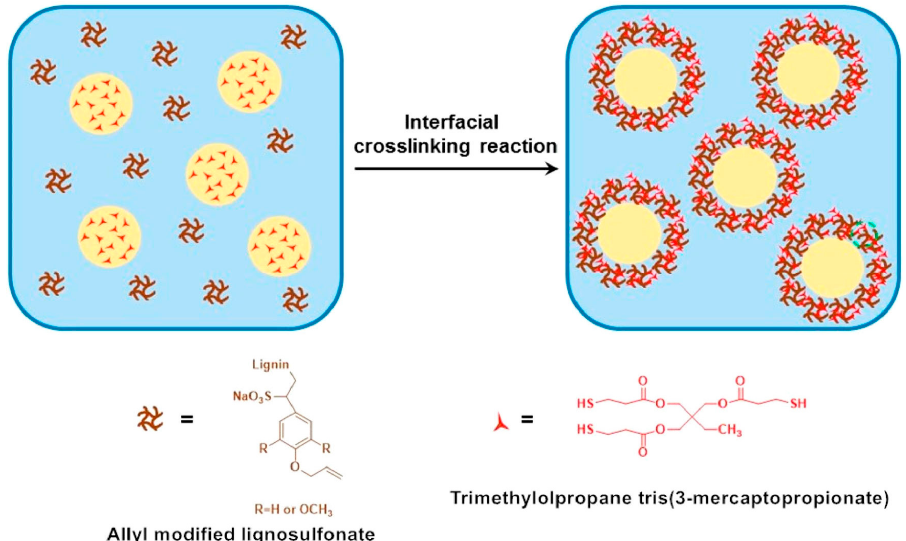
Figure 8. Preparation of lignin-based Nanocapsules via interfacial miniemulsion crosslinking reaction. Reprinted with permission from Chen et al. [86]. Copyright 2014 American Chemical Society.